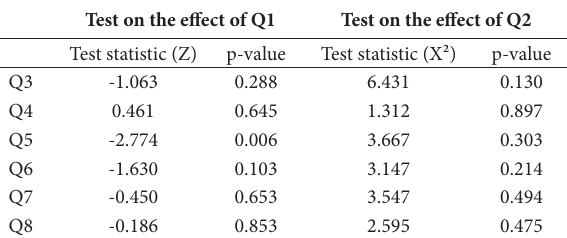
Table 3. Results of the Asymptotic Linear-by-Linear